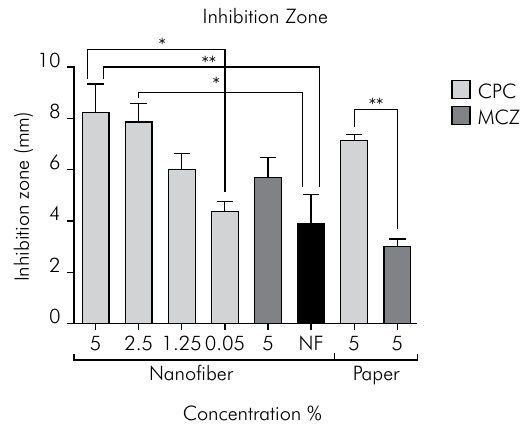
Figure. Histogram representing the mean ± SE values of the difference between the inhibition zone diameter and the final diameter of the disk in the susceptibility test against Candida albicans . Statistical results (ANOVA and Tukey Test) are also shown: * p < 0.05, ** p < 0.01. CPC: cetylpyridinium chloride. MCZ: miconazole. NF: nanofiber with no